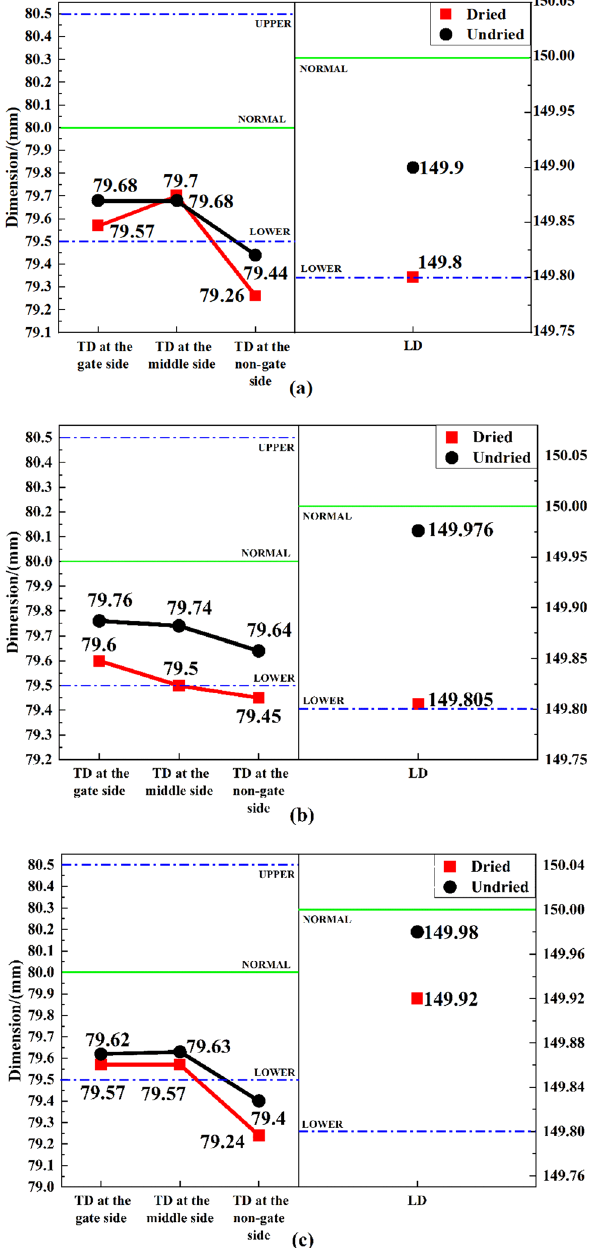
Figure 7: The transverse and longitudinal peripheral dimensions of the plate treated by the three routes: ( a ) I, ( b ) II, and ( c )